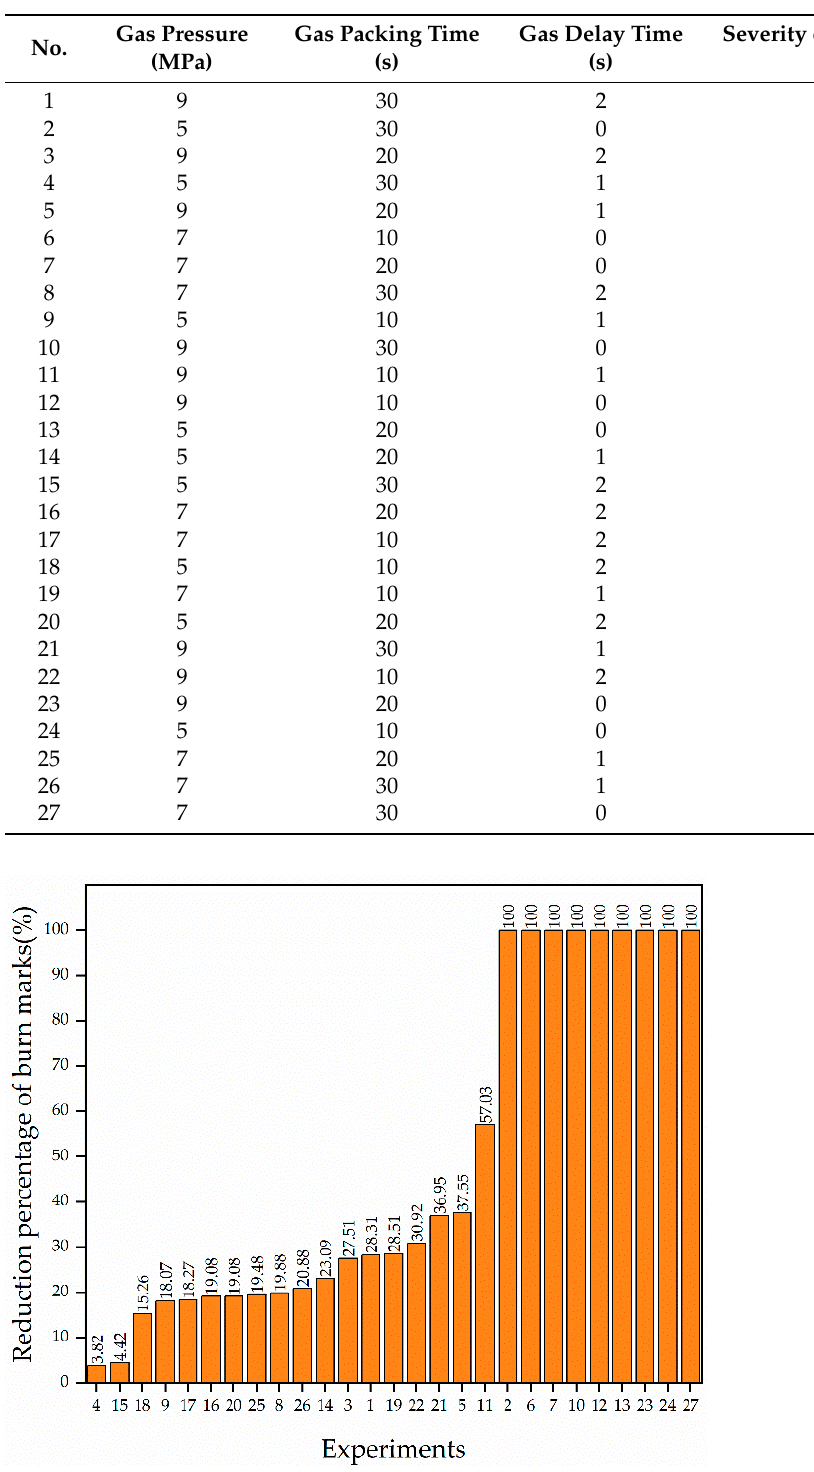
Table 3. The detailed gas parameters and severities of burn marks of parts molded by EGAIM.